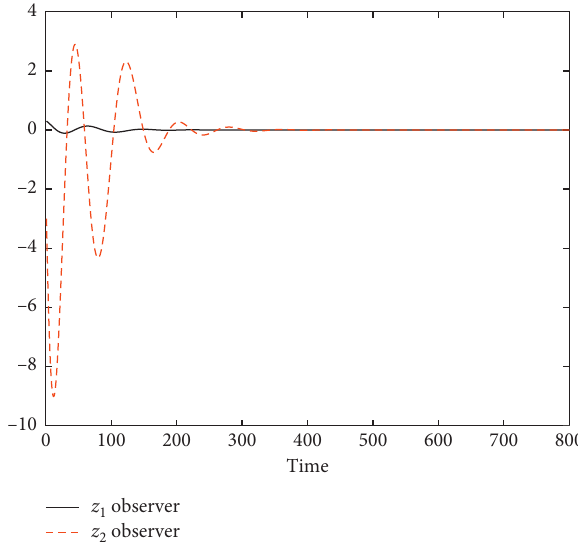
Figure 3: The trajectory of system observer state 􏽢 z